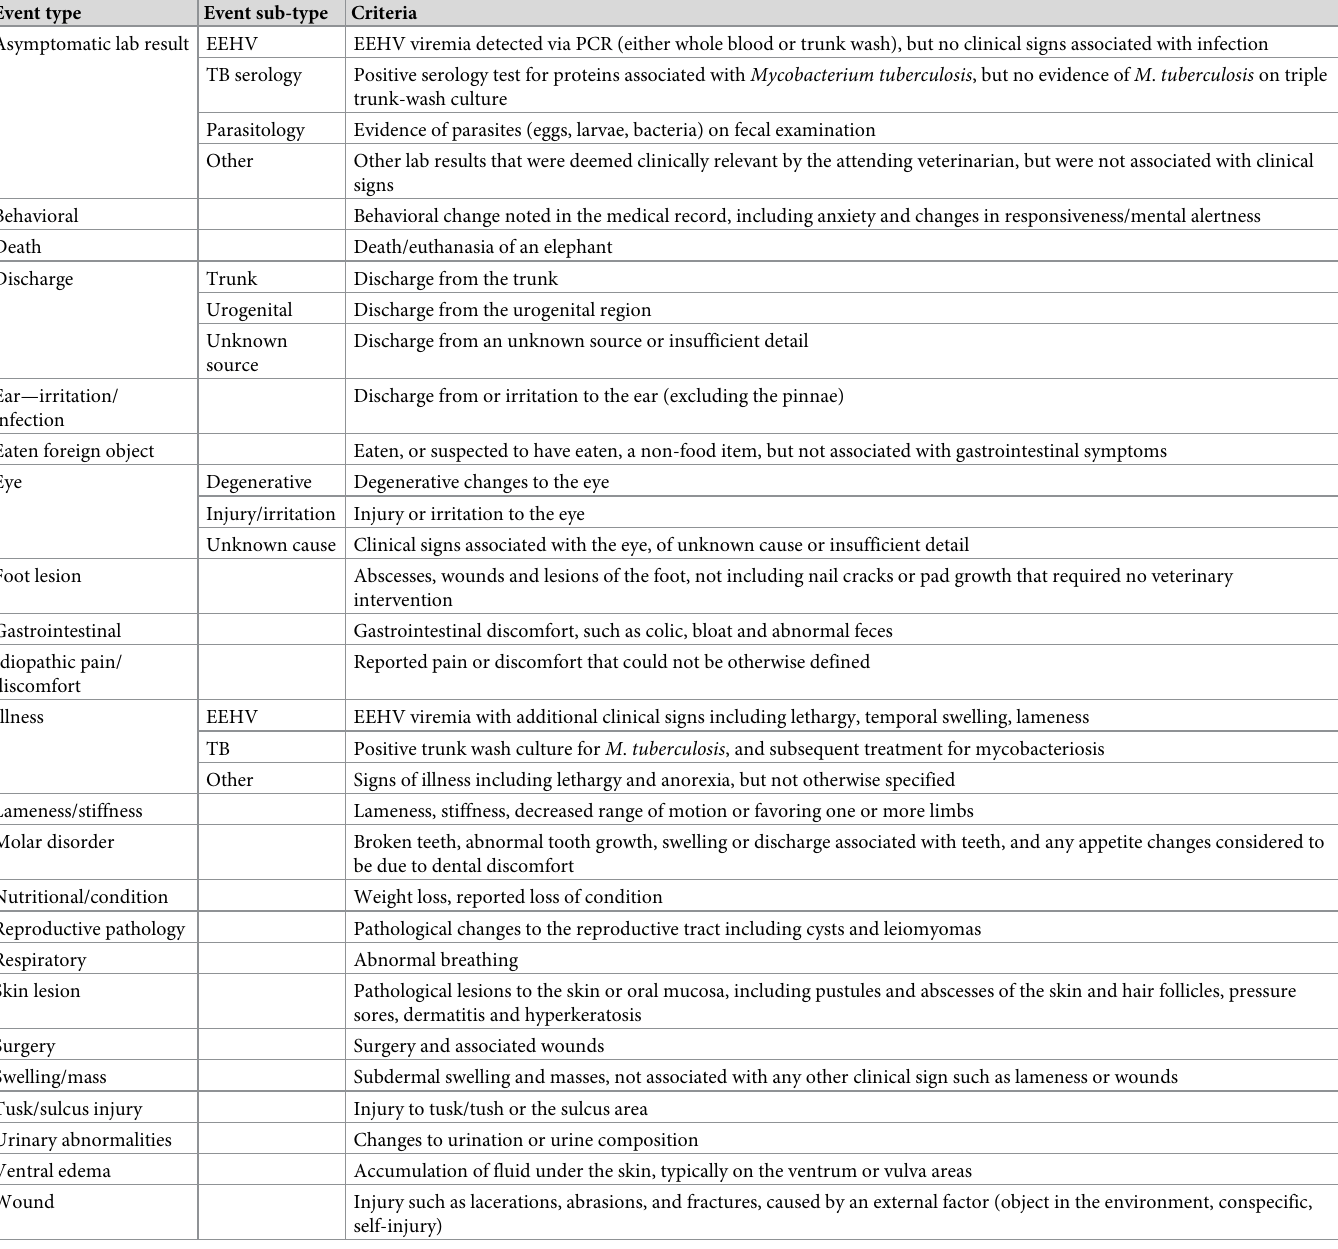
Table 2. Description of event type and subtype used to categorize clinical data recorded during the 12-month study period in African and Asian elephants in North American